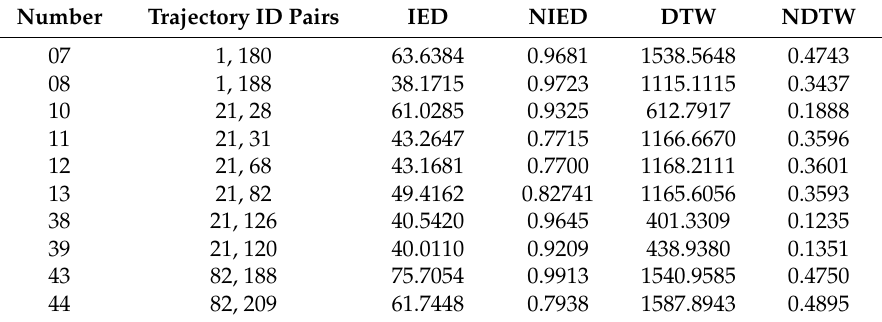
Figure 4. ( a ) Comparing between ED and DTW of trajectories; ( b ) Geographic distribution of compared three trajectories 21, 28, and 31. Table 3. The values of ED and DTW between